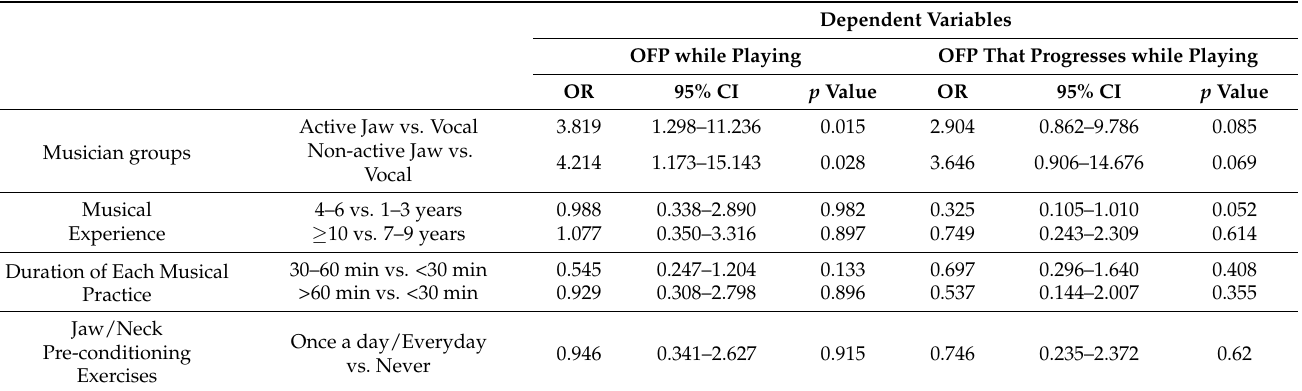
Table 6. Association of the musician groups, musical experience, musical practice duration, and muscular pre-conditioning exercises with the presence of performance-related orofacial pains (OFP) as described by odds ratio (OR) and confidence intervals